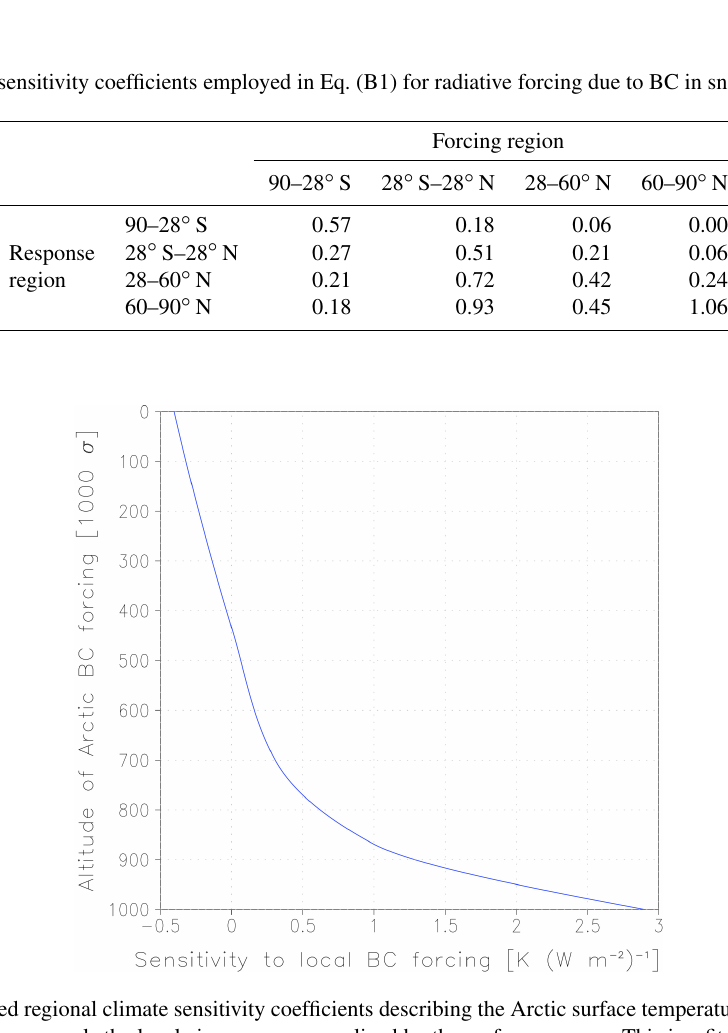
VR indicates the use of vertically resolved coefficients; see Fig. B1.